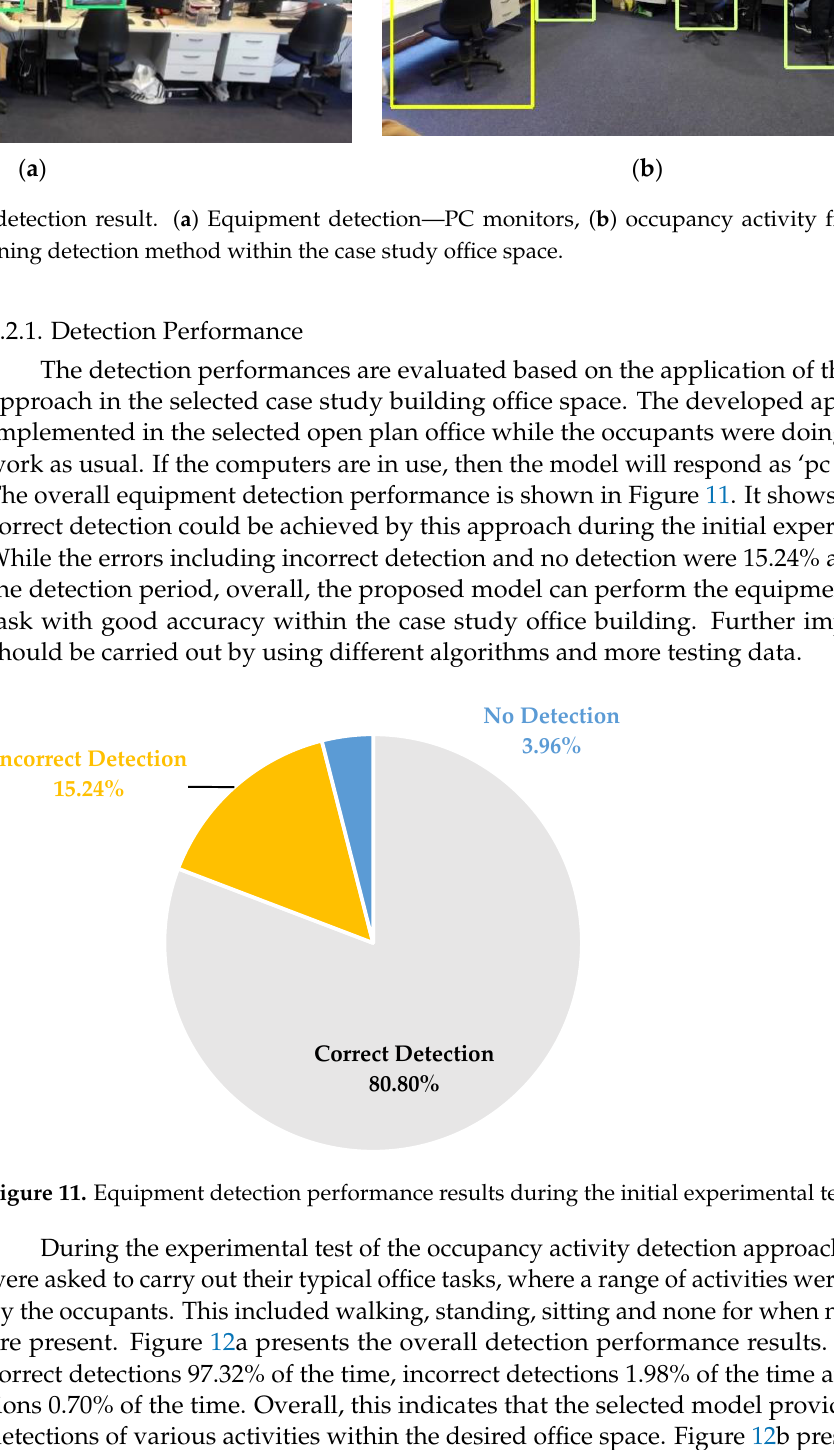
Figure 11. Equipment detection performance results during the initial experimental test.